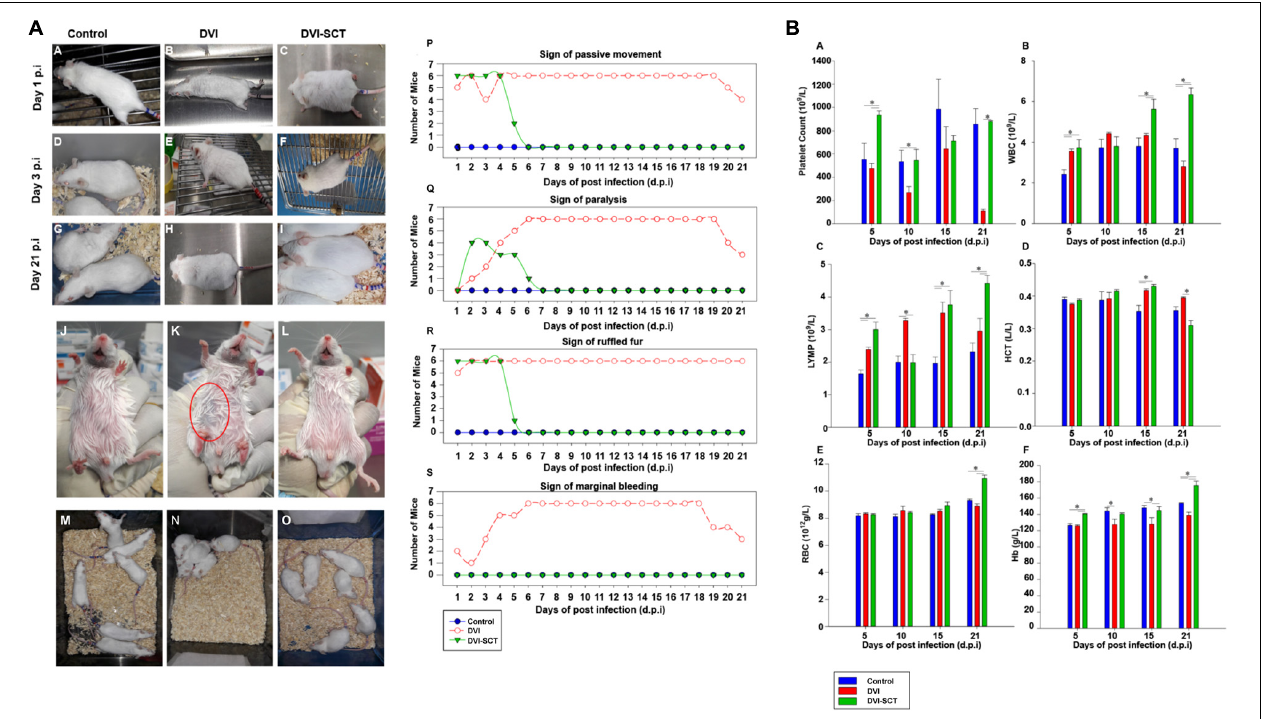
FIGURE 1 | Behavioral changes in experimental animals and clinical profile analysis. (A) Mouse behavioral and physical changes. (a–i) Mouse fur condition at different times during the experiment. (j–l) Sign of hemorrhage. (m–o) Mouse mobility. (p–s) The number of mice showing physical changes at different dpi. (p) Sign of passive movement, (q) Sign of paralysis, (r) Sign of ruffled fur, and (s) Sign of marginal bleeding. ( • ) Control, ( ◦ ) DVI, and ( (cid:72) ) DVI-SCT. (B) Comparison of hematological parameters for each group at different days post-infection (dpi). (a) Platelet count, (b) White blood cells (WBC), (c) Lymphocytes (LYMP), (d) Hematocrit (HCT), (e) Red blood cells (RBC), and (f) Hemoglobin (Hb). Legend: Control (blue bar), DVI (red bar), and DVI-SCT (green bar). The data were analyzed using one-way ANOVA, and differences were considered significant when p < 0.05